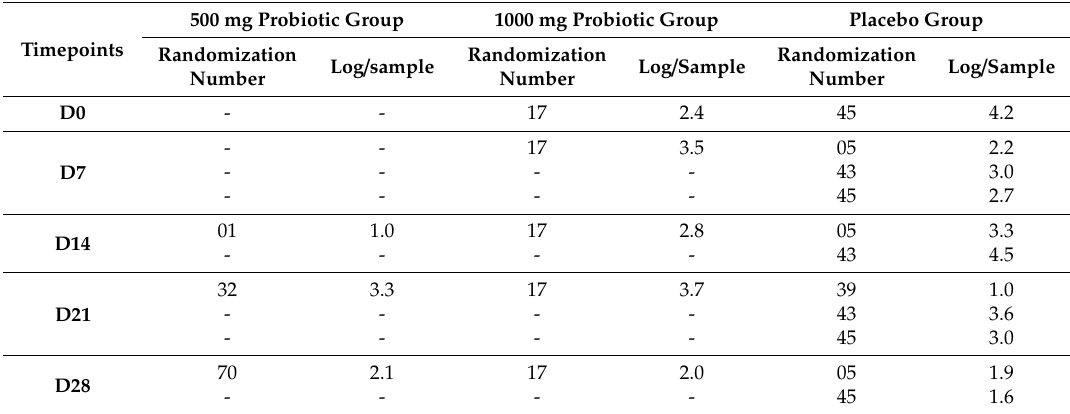
Table 5. Quantification of C. albicans in the vaginal samples where it was detected, at each study timepoint, expressed as log /